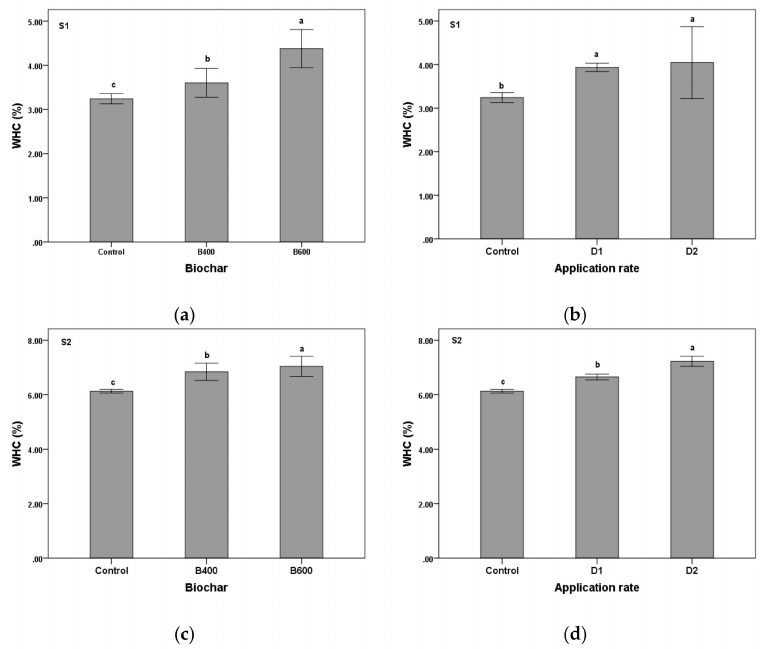
Figure 3. Main value and confidence interval at 95% of substrates water holding capacity (WHC) in two di ff erent texture of growing substrates, temperature of biochar applied (400 ◦ C—B400 and 600 ◦ C—B600) and application rate (D1: 1.5 wt. %; D2: 3 wt. %). ( a ) e ff ect of final pyrolysis temperature of